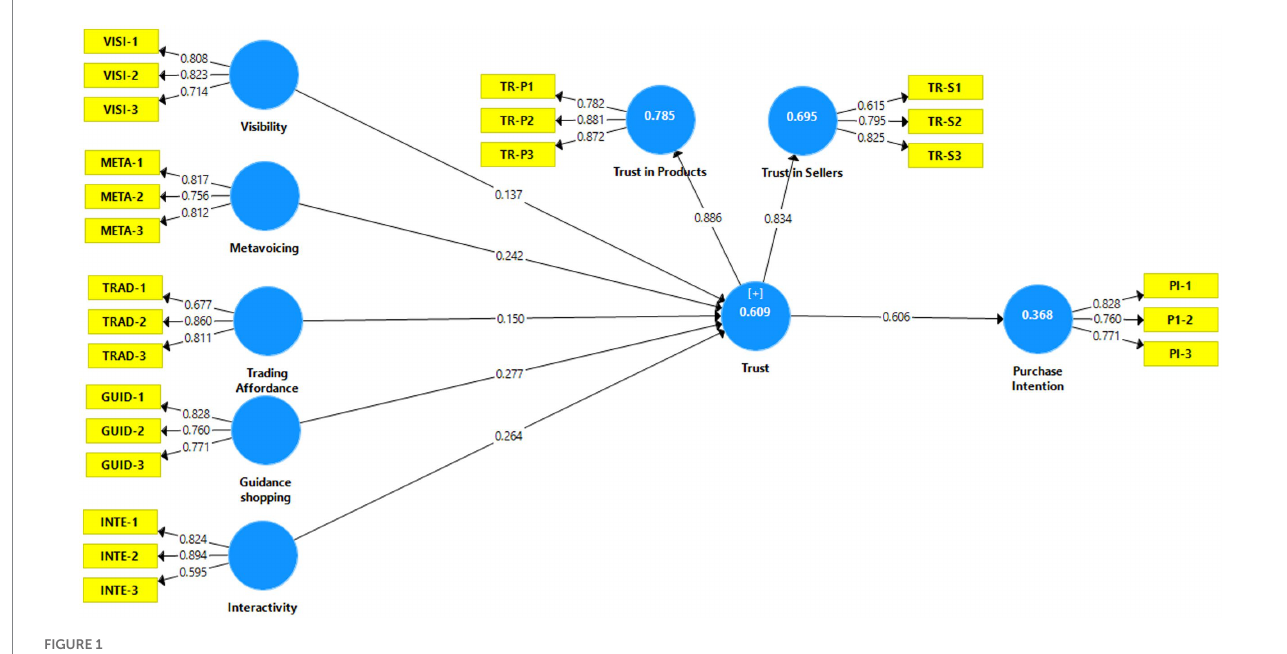
FIGURE 1 Measurement